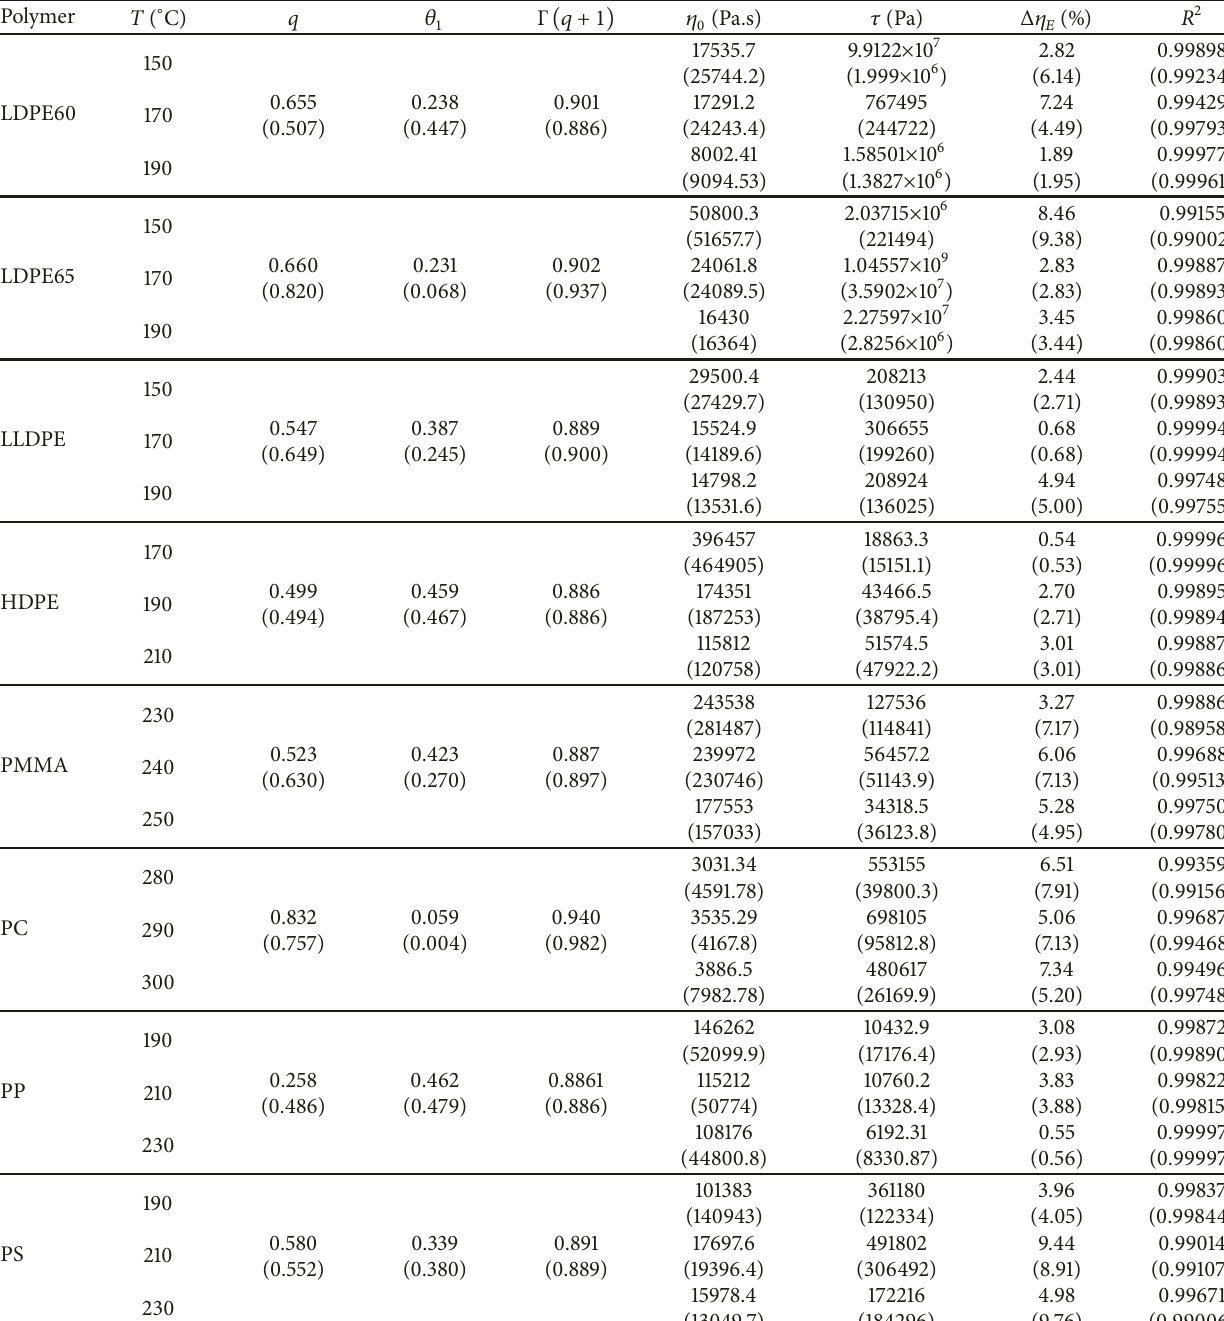
Table 1: Rheological parameters computed from (5) and (6) in parenthesis in terms of three different temperatures at ambient pressure.